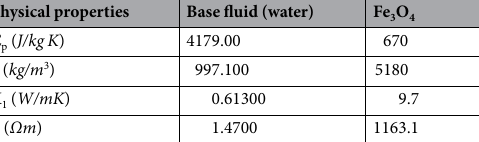
Table 1. Thermo-physical characteristics of the base fluid (water) and nanoparticles (Fe 3 O 4